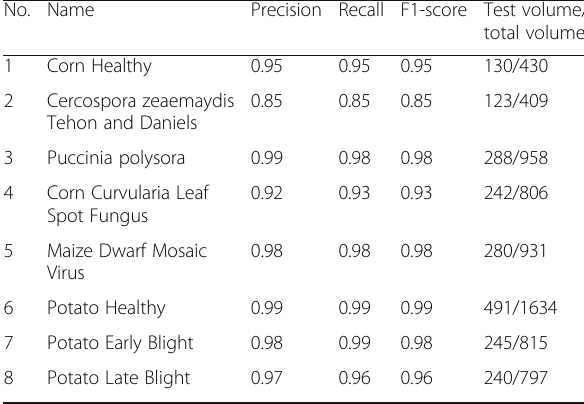
Table 7 Recognition results of intercropping corn and